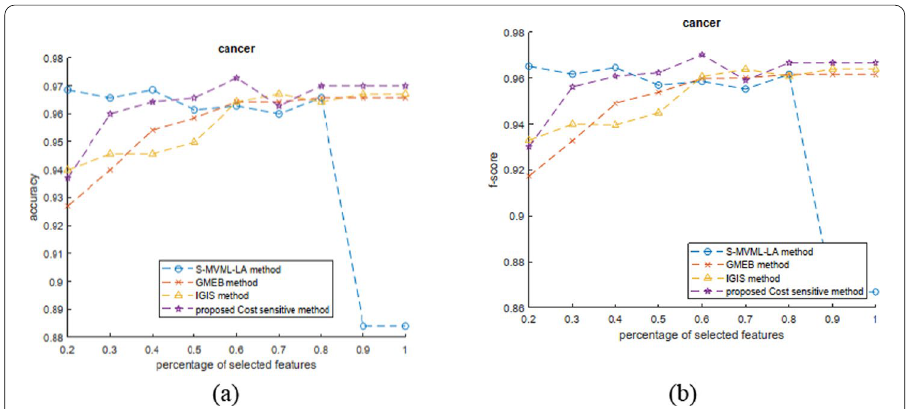
Fig. 2 The performance of the proposed cost sensitive method, S-MVML-LA [15], GMEB [10] and IGIS [20] versus the changes in percentage of selected features numbers over the cancer dataset. a Accuracy, b f-score